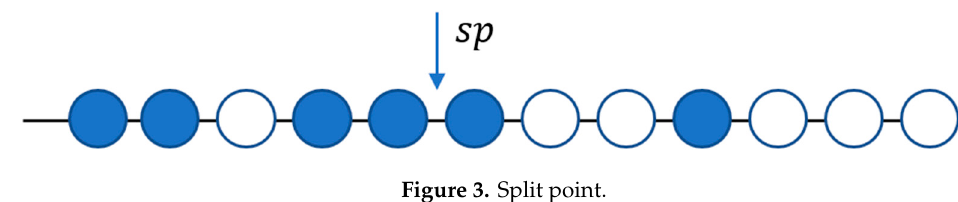
Table 1. Summary of data sets and the combination of parameters in the